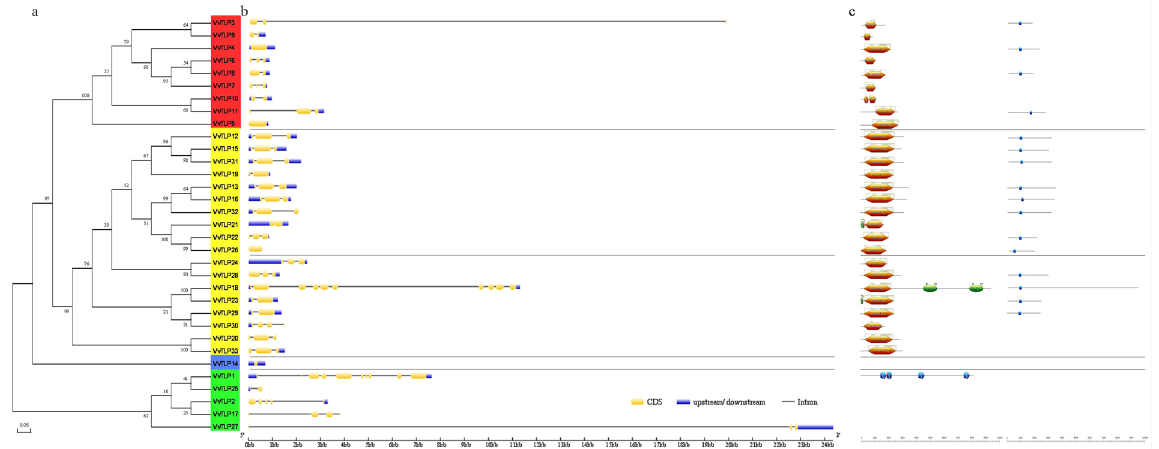
Figure 1. Genome wide organization of grape TLP ( VvTLP ) genes. ( a ) Phylogenetic tree based on the protein sequences of 33 VvTLP genes. Phylogenetic tree was constructed using the neighbor-joining method with MEGA5. Four subfamilies (Type I, II, III and IV) were analyzed and colored in red, yellow, blue and green, respectively. Bootstrap values at the nodes from 1000 replicates were used to assess the robustness of the tree. The scale is in amino acid substitutions per site. ( b ) Exon-intron structure of VvTLP genes: yellow indicates coding sequence (CDS), blue indicates untranslated 5 ′ - and 3 ′ - regions, black indicates introns. ( c ) Structures of VvTLP proteins: brown indicates Thaumatin_2 domain, blue rectangle indicates Thaumatin_1 domain, green ellipse in VvTLP21 and VvTLP23 indicates a PROKAR-lipoprotein domain, green ellipse in VvTLP18 indicates a FE2OG_OXY domain, blue pentagon indicates an ARM_REPEAT domain, blue ellipse indicates a HEAT_ REPEAT domain, gray line indicates a disulfide bridge, gray icon indicates active sites, green line indicates undefined bridge/range.